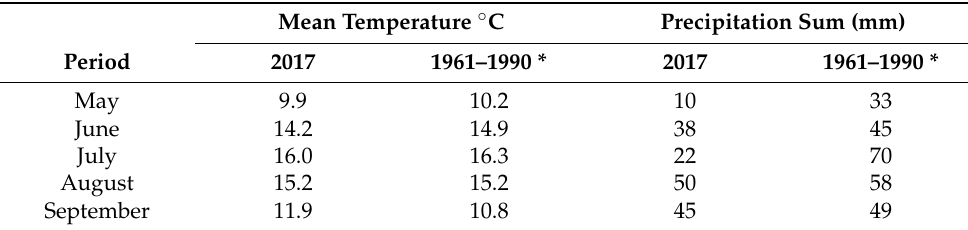
Table A1. Mean monthly temperature and precipitation sum for the 2017 growing season and the reference period 1961–1990.